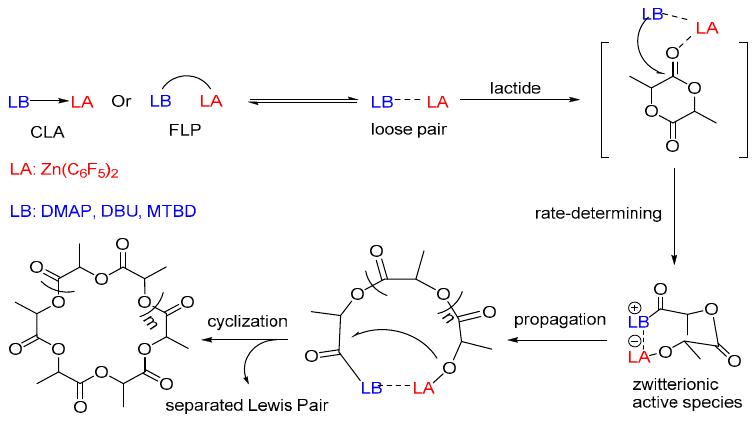
Scheme 5. Proposed mechanism for the ring-opening polymerization of lactide catalyzed by Lewis pairs.